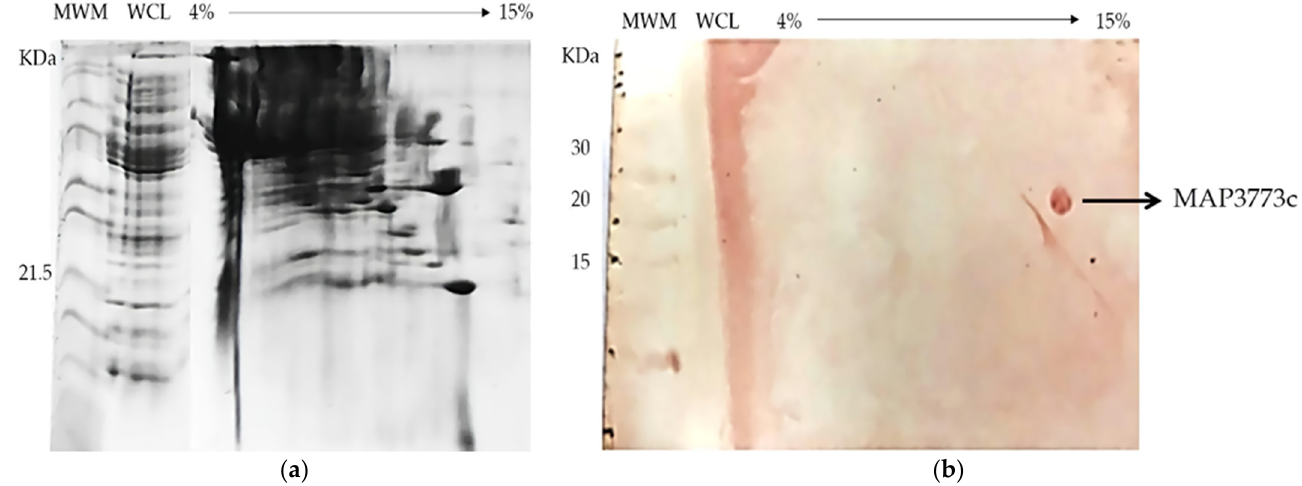
Figure 10. In ( a ), BN-PAGE of extract protein cellular lysates from E. coli host cell expressing recombinant MAP3773c, followed by ( b ) an immunoblot assay to separate possible complexes representing MAP3773c. WCL (whole-cell lysate).